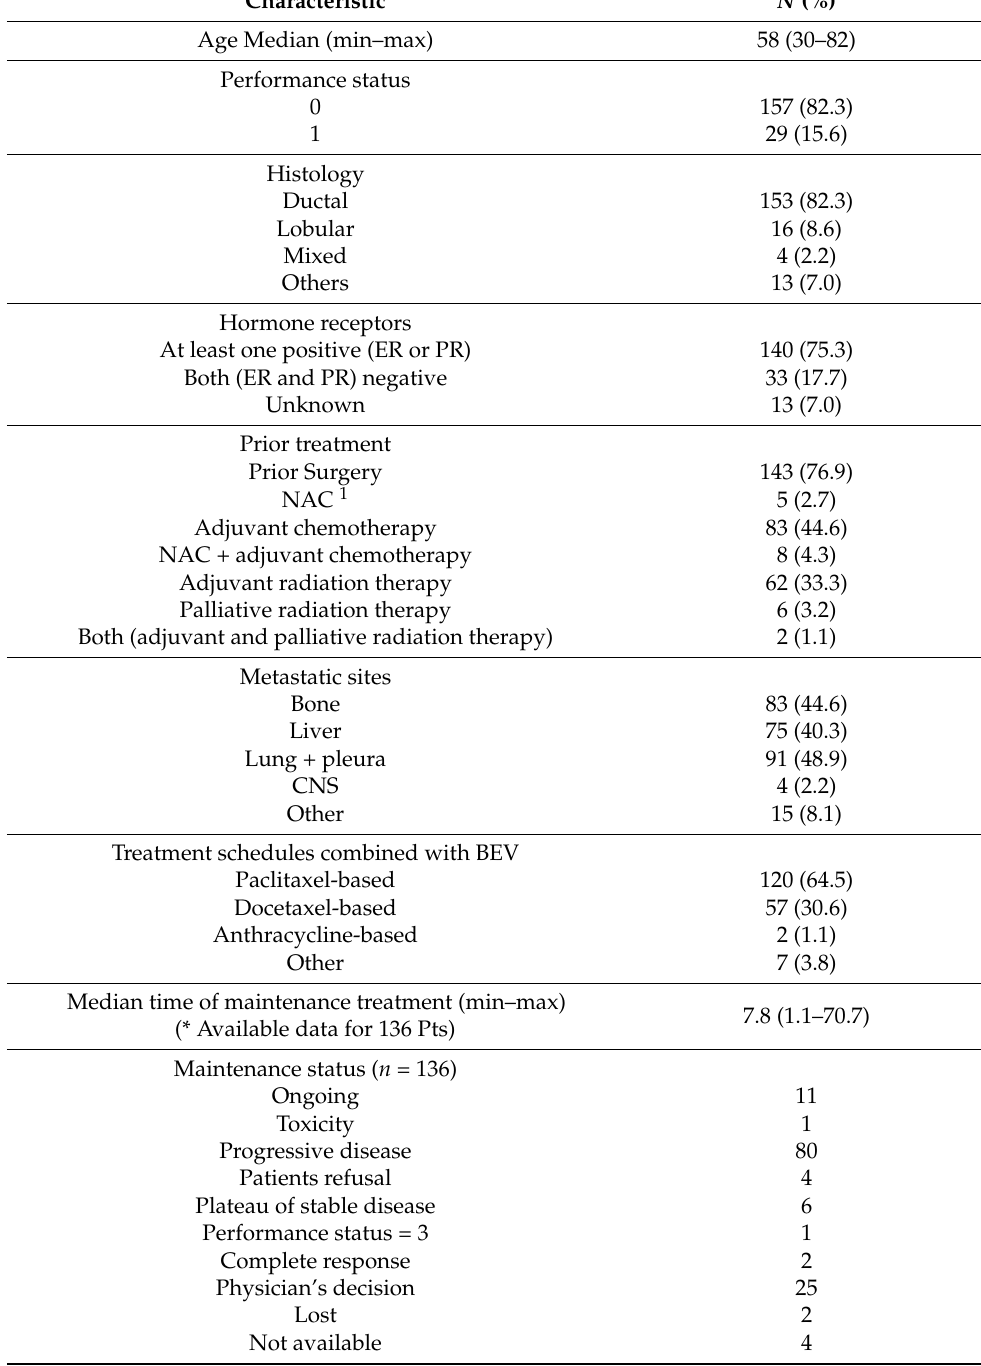
Table 3. Characteristics of all patients without disease progression at chemotherapy discontinua- tion/completion, irrespective of HR status, who received maintenance treatment with BEV and/or ET ( n =